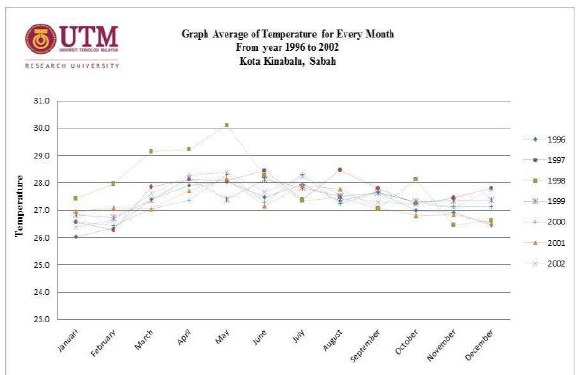
Figure 17. Graph Average of Temperature for Every